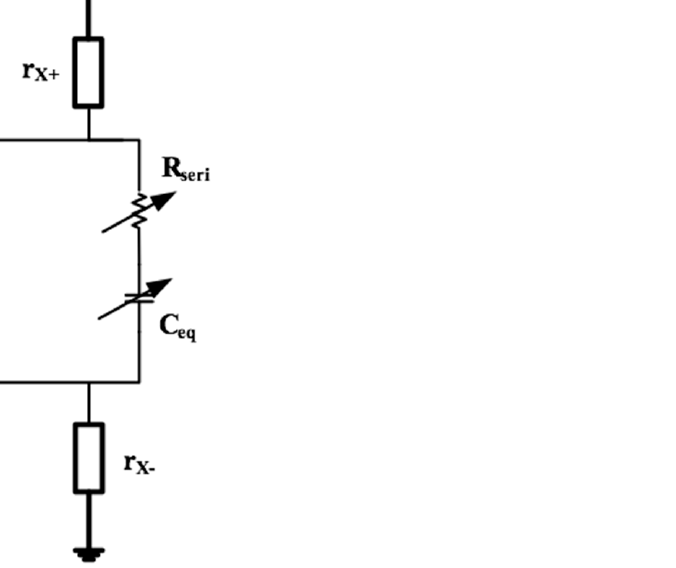
Figure 5. The equivalent circuit of the proposed floating C multiplier.